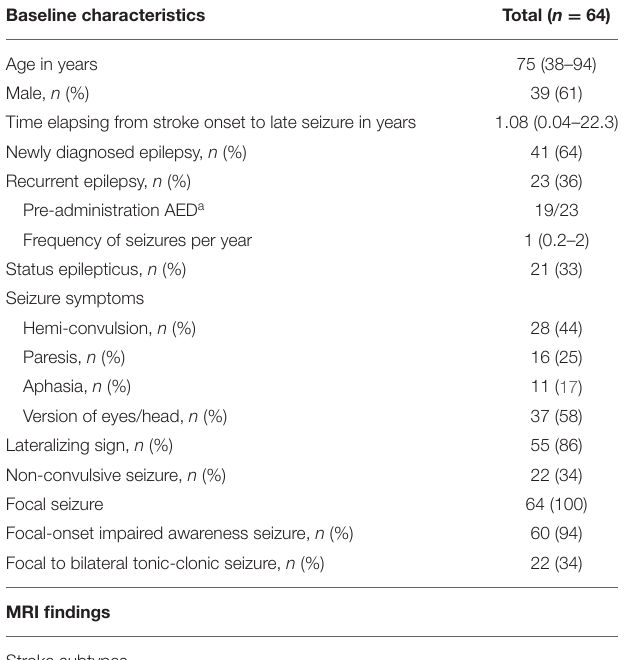
TABLE 1 | Baseline